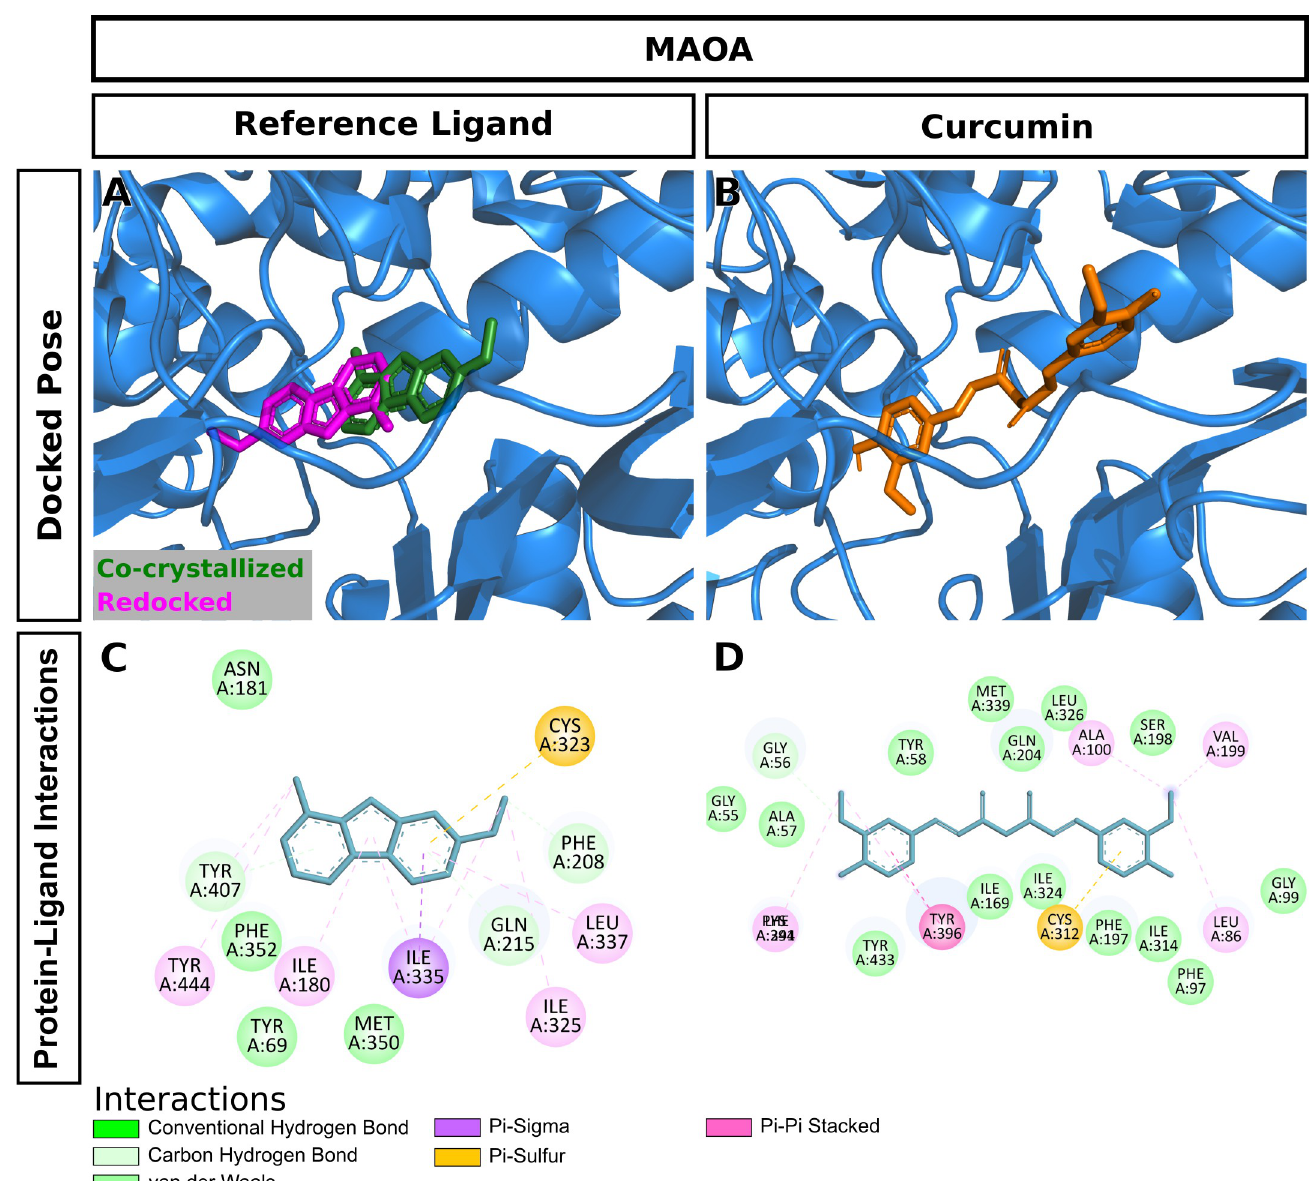
Fig 12. Molecular docking of curcumin to MAOA. (A) Redocking of the bound ligand. (B) Docking pose of curcumin. (C) Interactions of the bound ligand with the protein. (D) Predicted interactions of curcumin with the